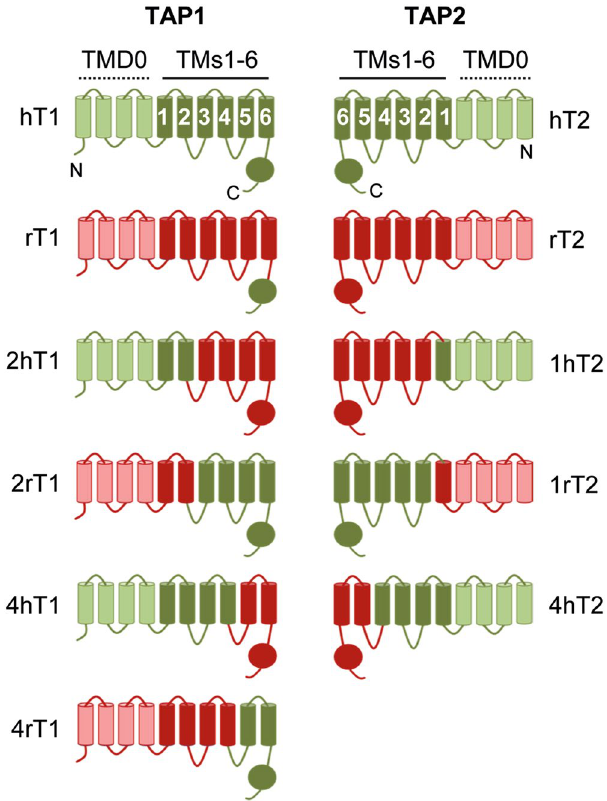
Figure 5. A schematic depiction of TAP1 and TAP2 human/rat chimeras. Human sequences are shown in green and rat sequences in red. TMs of the TMD0 are shown in a lighter